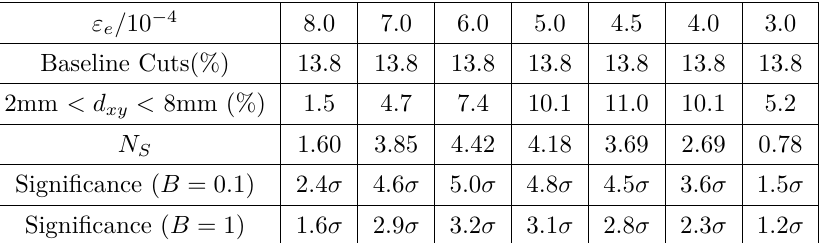
8 mm cuts, for several values of ε of xy ≤ e in the e + e − ‘ + ‘ − channel at Belle II with 50 ab − 1 S